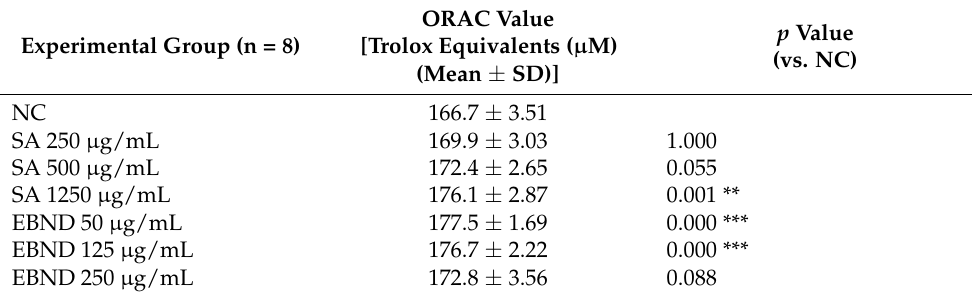
Table 1. Effects of EBND and SA on cellular ORAC capacity in HaCaT cells. Experimental Group (n = 8)